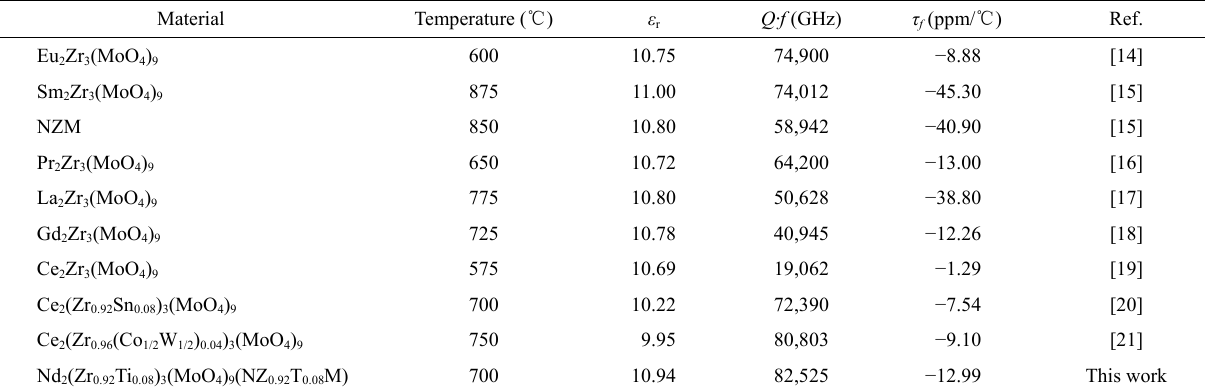
Table 1 Microwave dielectric properties of Ln 2 Zr 3 (MoO 4 ) 9